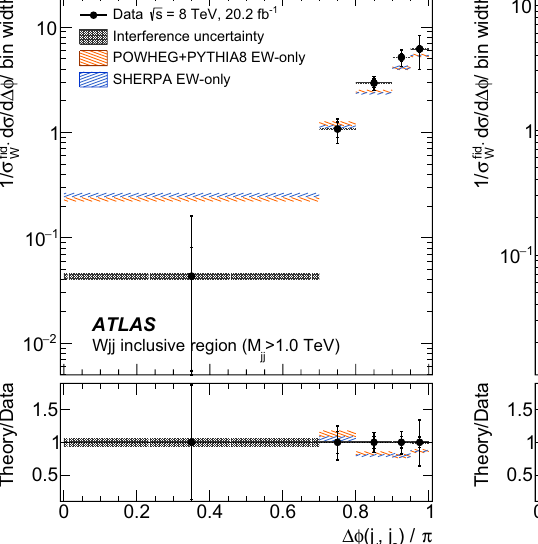
Both statistical ( inner bar ) and total ( outer bar ) measurement uncer- tainties are shown, as well as ratios of the theoretical predictions to the data (the bottom panel in each distribution)